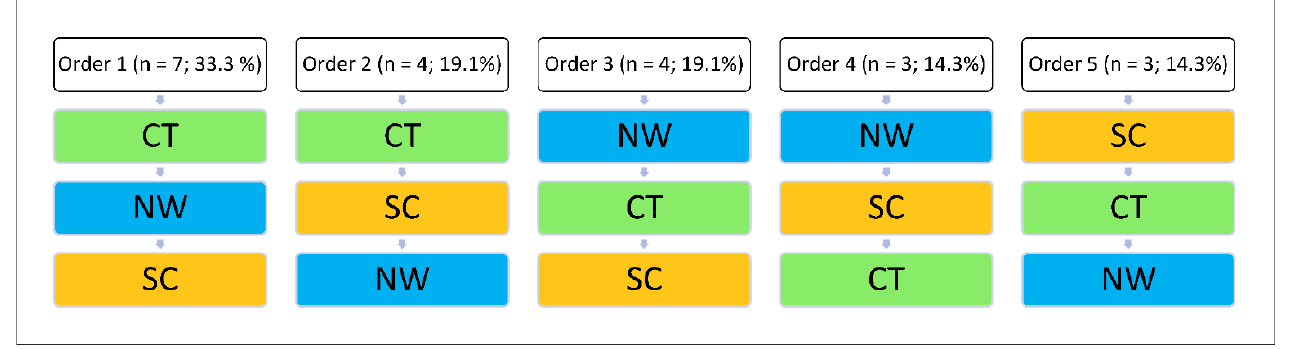
Figure 1. Five different sequences for the three interventions climbing therapy (CT), Nordic walking, (NW) and sedentary control condition (SC).